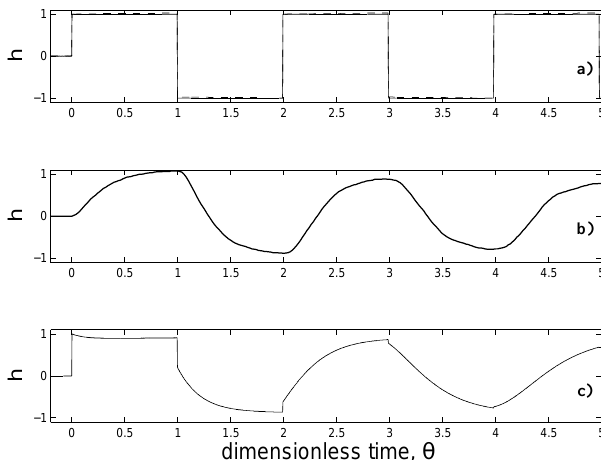
Figure 1. Dimensionless pressure signal in a single pipe due to the instantaneous closure of the end valve: (a) continuous line: Allievi-Joukowsky model (frictionless and elastic pipe) and dashed line: steady-state approach (steady-state friction and elastic pipe), (b) typical experimental data in elastic pipes, and (c) typical exper- imental data in viscoelastic pipes.